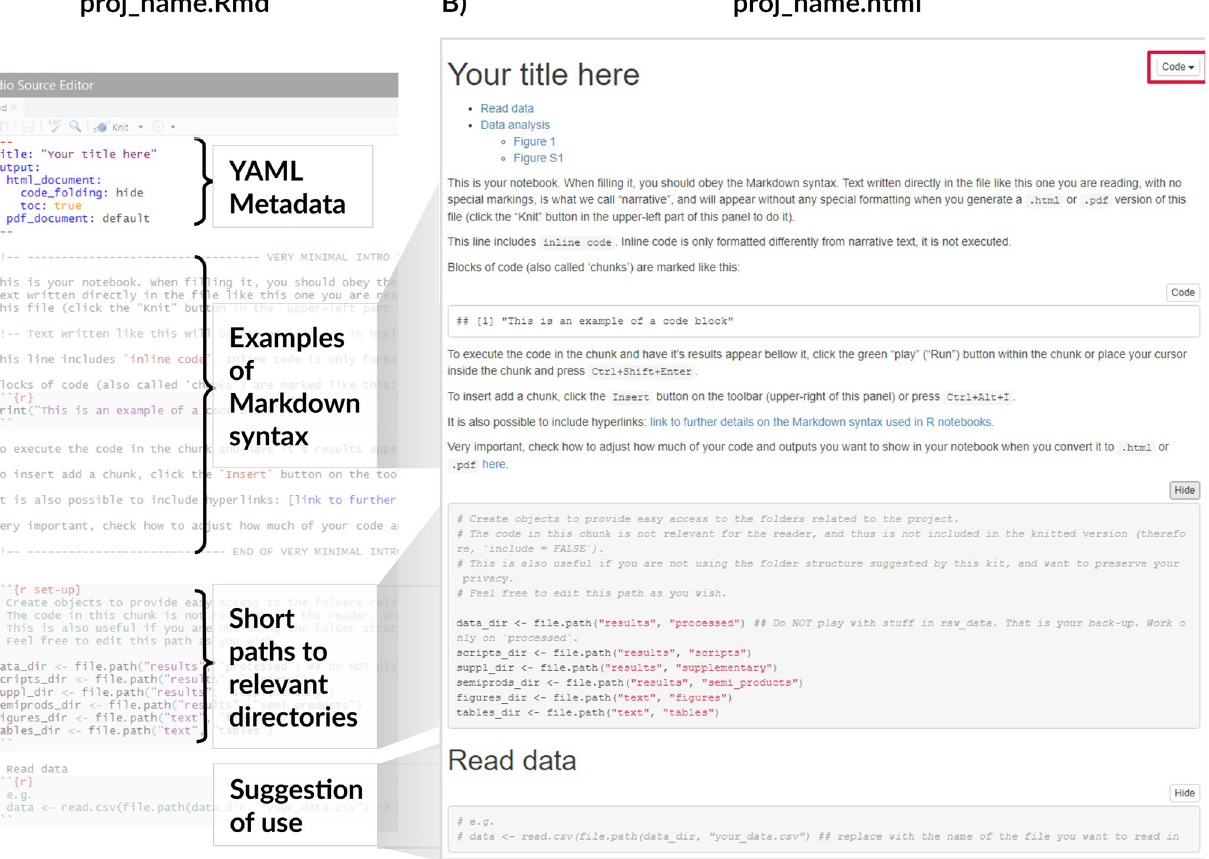
PLOS Computational Biology | https://doi.org/10.1371/journal.pcbi.1010356 September 15,